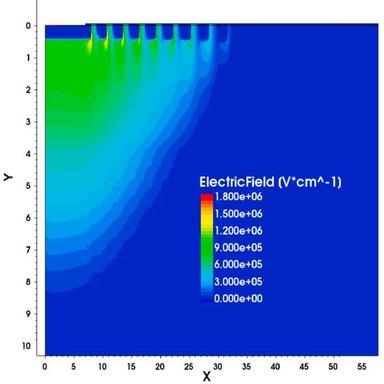
Electric field distribution in the diode at 400 V reverse bias.